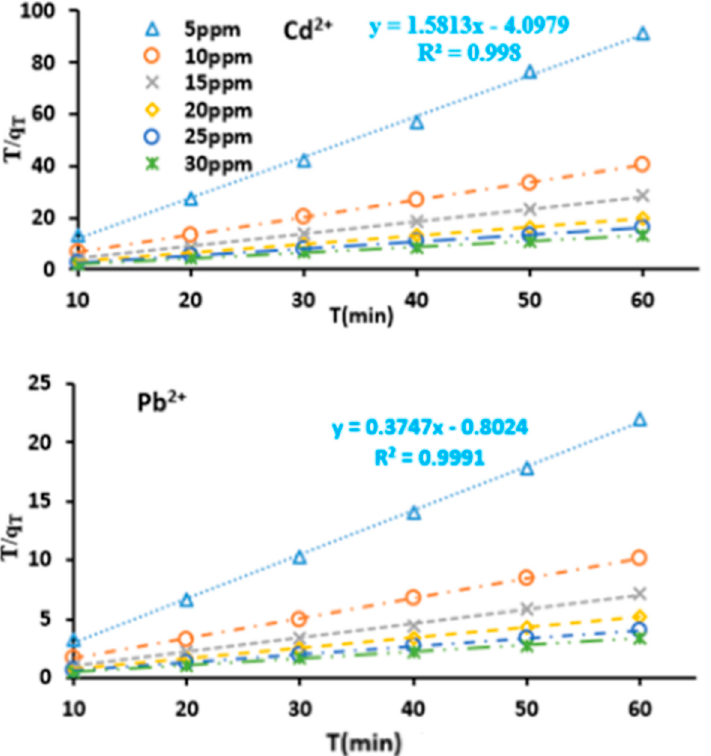
Figure 9. Pseudo-Second-Order kinetics graph for adsorption of metal ions.